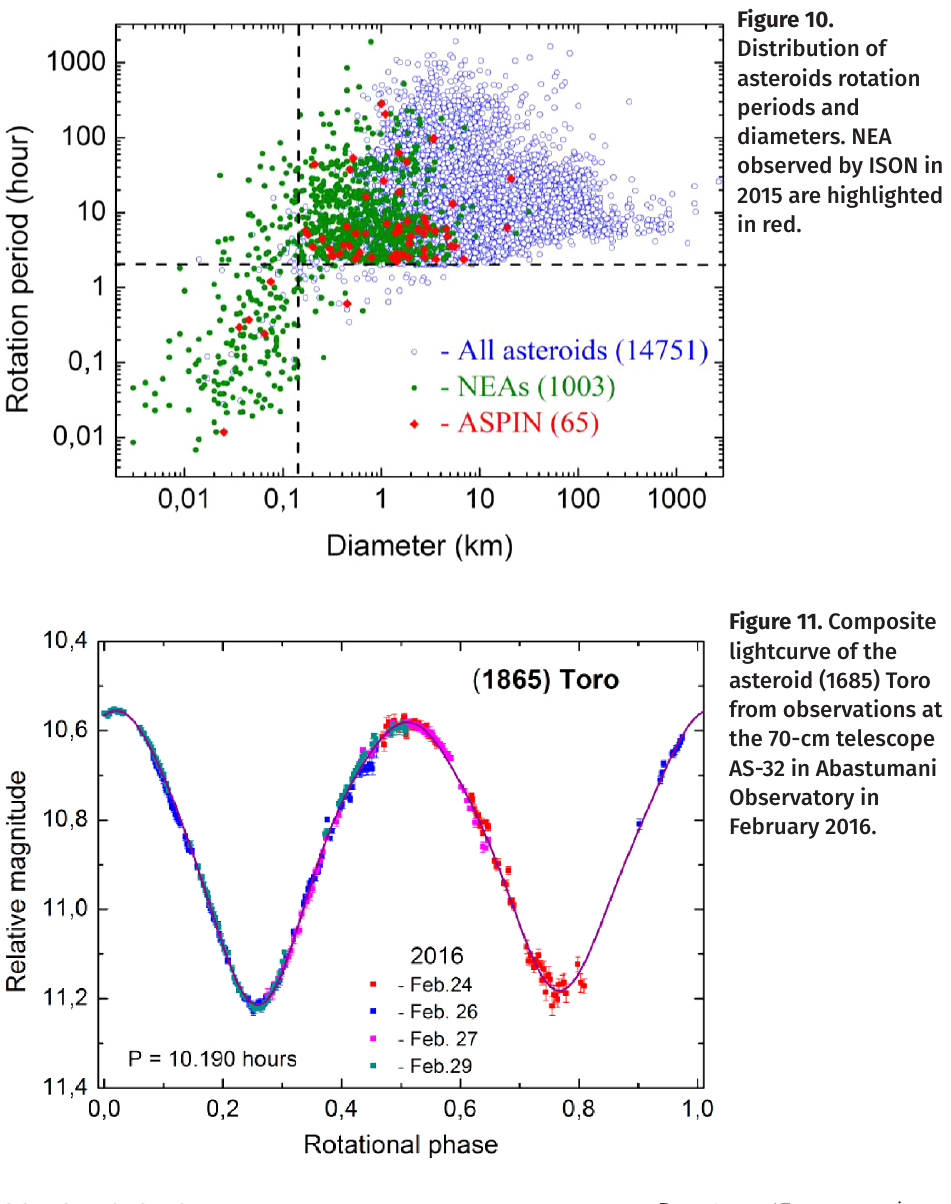
Figure 10. Distribution of asteroids rotation periods and diameters. NEA observed by ISON in 2015 are highlighted in